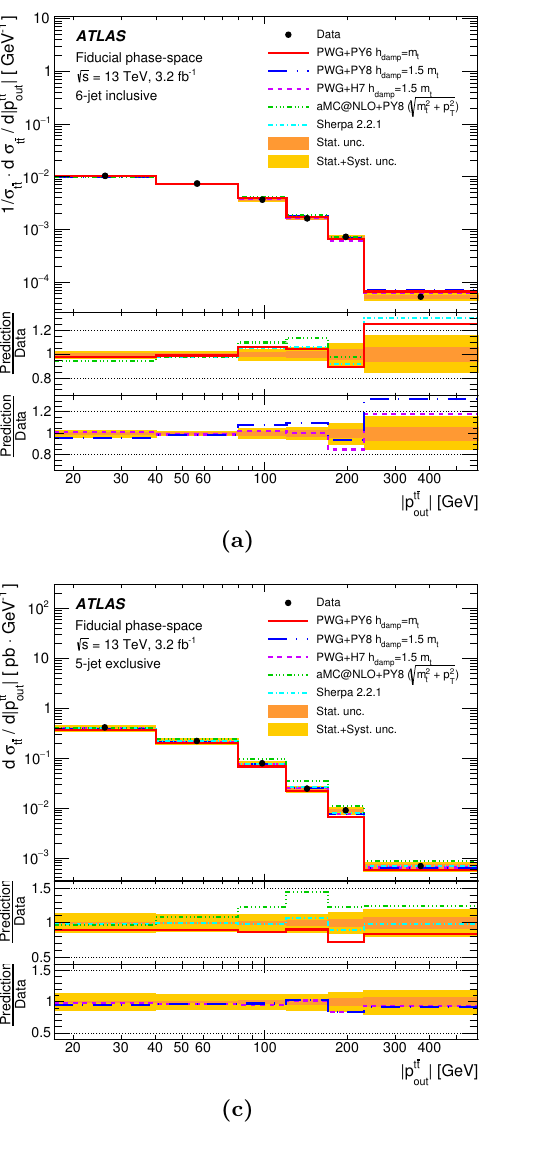
Figure 10 . Di(cid:11)erential cross sections in the (cid:12)ducial phase space as a function of malised (a) in the 6-jet inclusive con(cid:12)guration, absolute (b) in the 4-jet exclusive, (c) 5-jet exclusive and (d) 6-jet inclusive con(cid:12)gurations. The shaded area represents the total statistical and system- atic